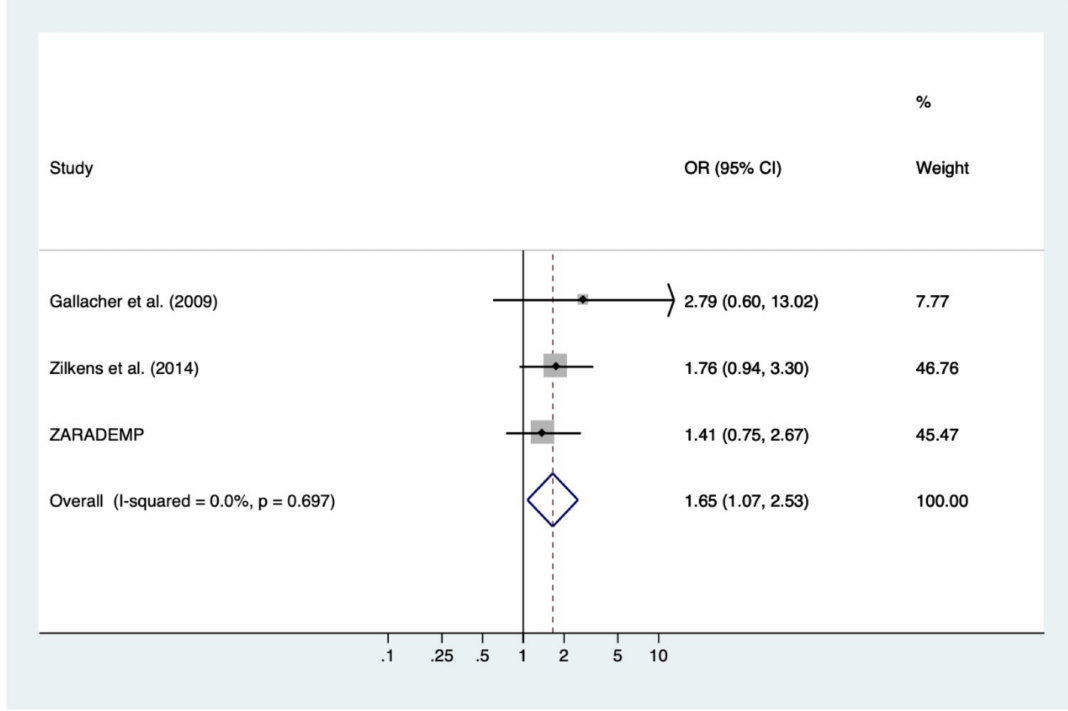
Figure 1. Forest plot showing individual and combined estimates for the risk of VaD associated with